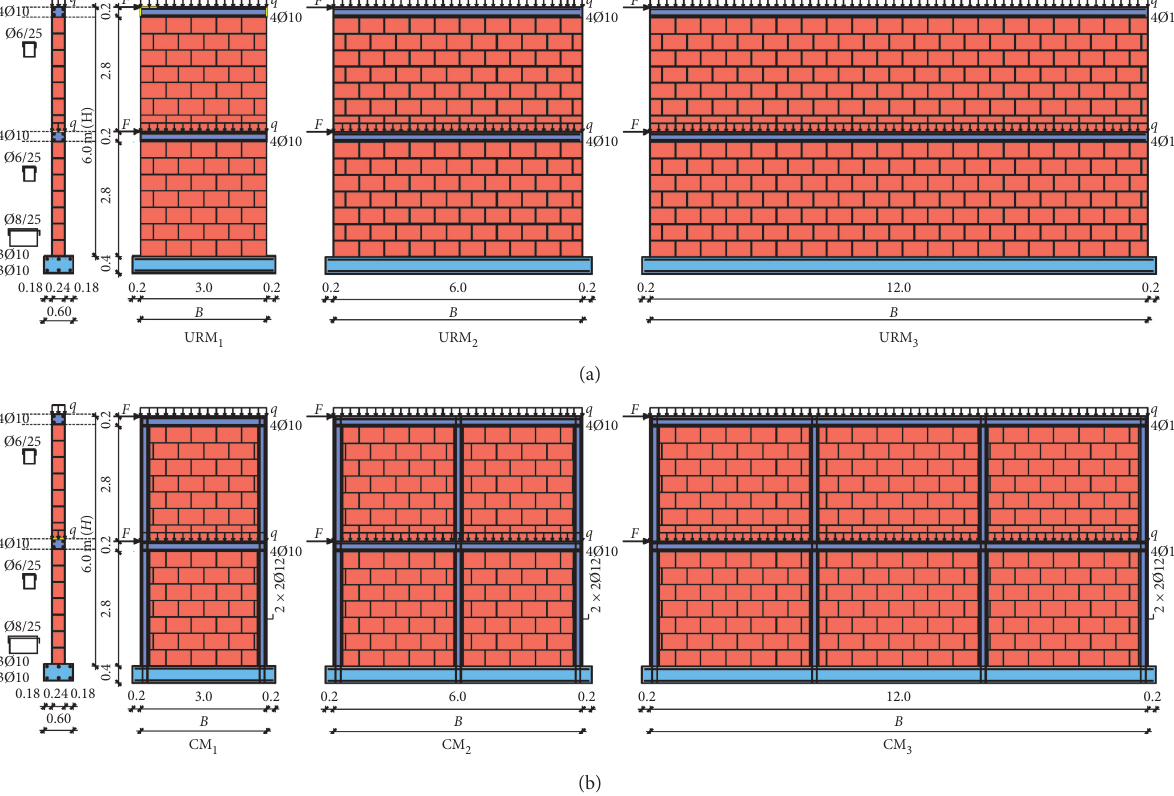
Figure 7: Analysed masonry walls: (a) unreinforced masonry walls; (b) confined masonry